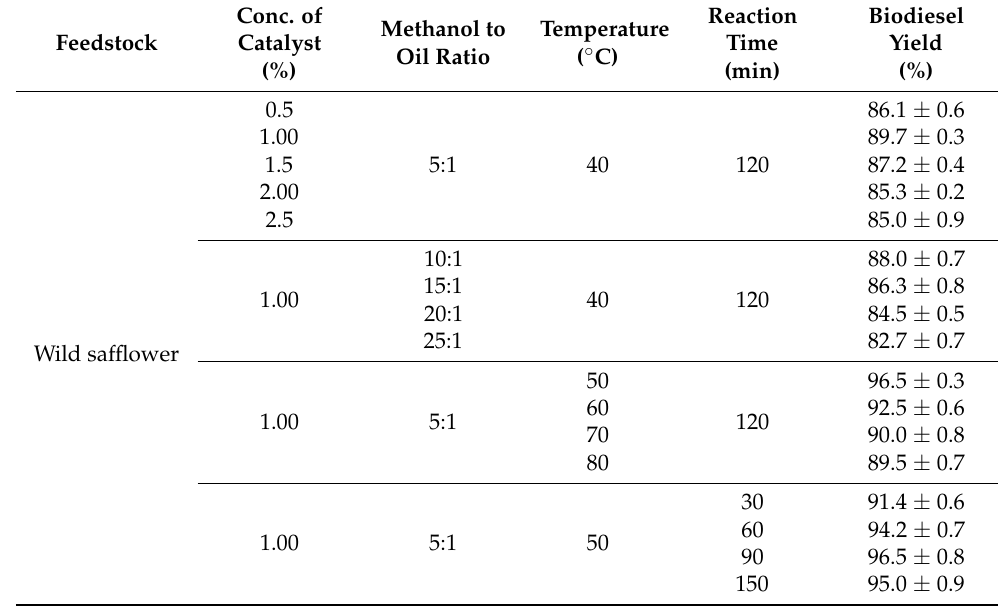
Table 5. Yield of biodiesel from wild safflower oil with changes in reaction parameters. Conc. of Feedstock Catalyst